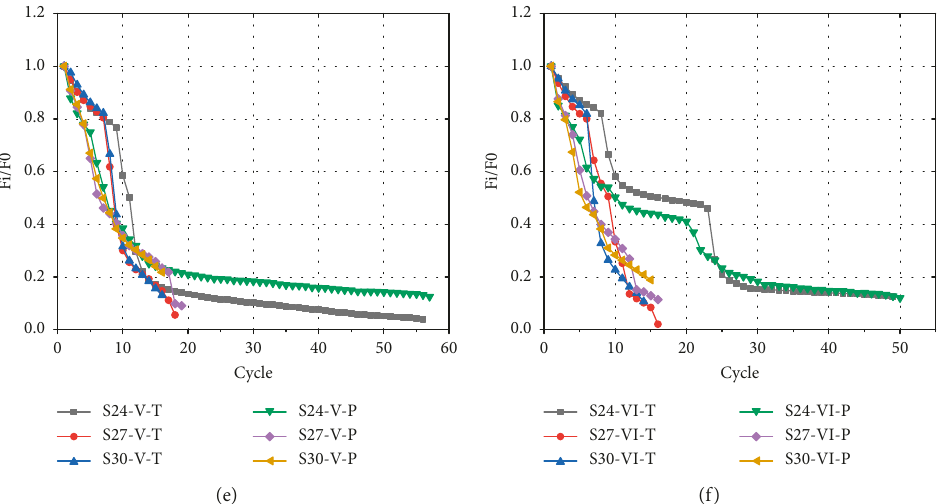
Figure 15: Comparison of bearing-capacity degradation curves. (a) Loading system I. (b) Loading system II. (c) Loading system III. (d) Loading system IV. (e) Loading system V. (f) Loading system